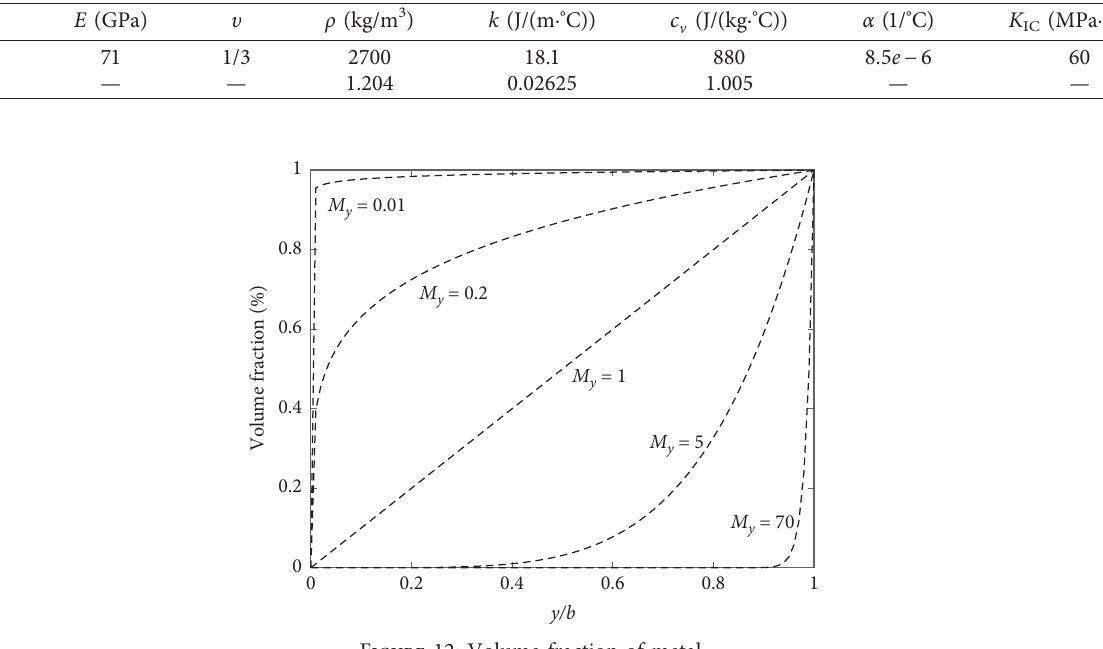
Figure 12: Volume fraction of metal.